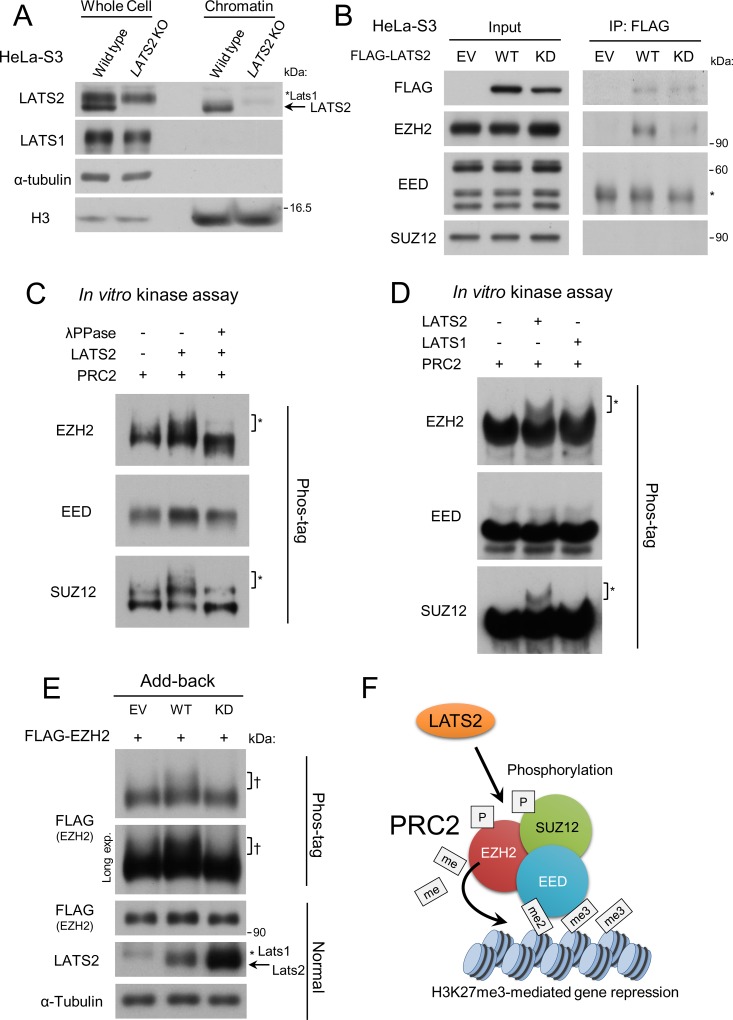
LATS2 associates with PRC2 and phosphorylates EZH2 on chromatin.(A) Western blotting of LATS2 in LATS2 KO HeLa-S3 cells. Arrow represents LATS2 signals. ‘*LATS1’ indicates LATS1 signals. (B) Co-immunoprecipitation of endogenous PRC2 with FLAG-tagged LATS2 from transiently transfected HeLa-S3 cells. Input represents 10% of the total solubilized chromatin fraction used for each immunoprecipitation. Right, anti-FLAG precipitates immunoblotted to detect FLAG-tagged proteins and endogenous PRC2. EV, empty vector. WT, kinase active. KD, kinase-dead mutant. The asterisk represents non-specific signals. (C) Phos-tag–based in vitro kinase assay demonstrating that LATS2 can phosphorylate PRC2. Recombinant PRC2 complex was incubated with recombinant LATS2 in the presence of ATP. Phosphorylation of PRC2 components was assessed by western blotting in the presence of Phos-tag. The asterisks indicate phosphorylation-dependent motility shifts. Phosphatase treatment demonstrated that the motility shift was dependent upon phosphorylation. (D) Phos-tag–based in vitro kinase assay including recombinant LATS1 kinase. (E) Phos-tag–based western blotting of add-back cells overexpressing FLAG-tagged EZH2. The dagger (†) indicates the phosphorylation-dependent motility shift. The arrow indicates LATS2 signals. ‘*LATS1’ indicates LATS1 signals. EV, empty vector. WT, kinase active. KD, kinase-dead mutant. (F) Model of the LATS2 signal that supports PRC2 functions.